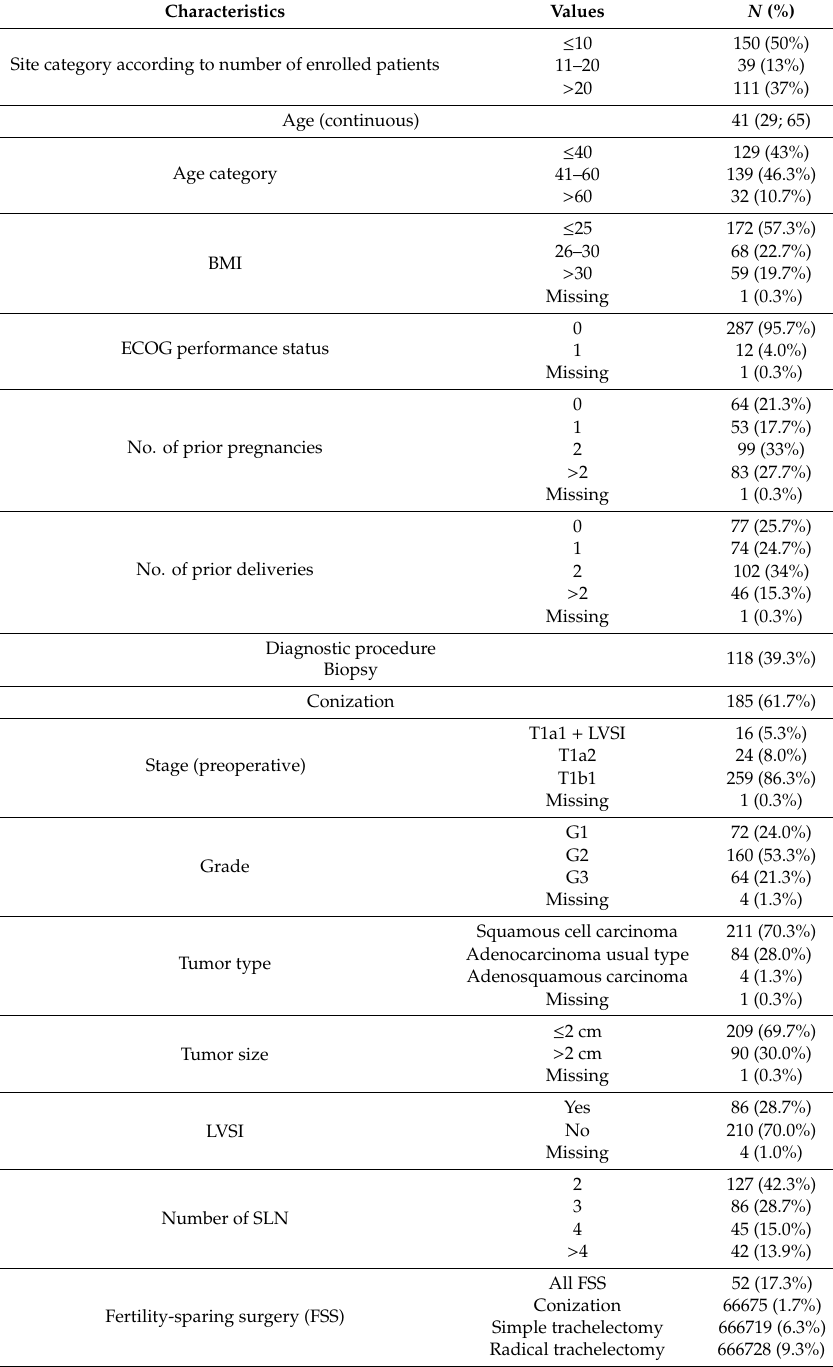
Table 1. Preoperative characteristics of patients ( N =